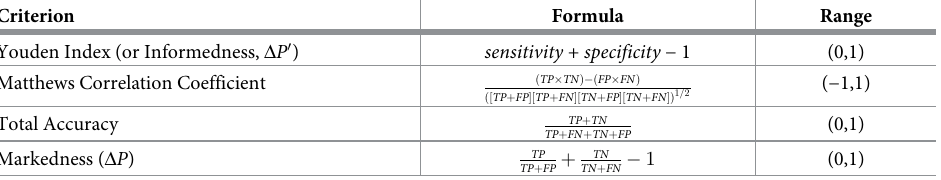
Table 1. Cutpoint selection criteria based on evaluation of empirical ROC curves.